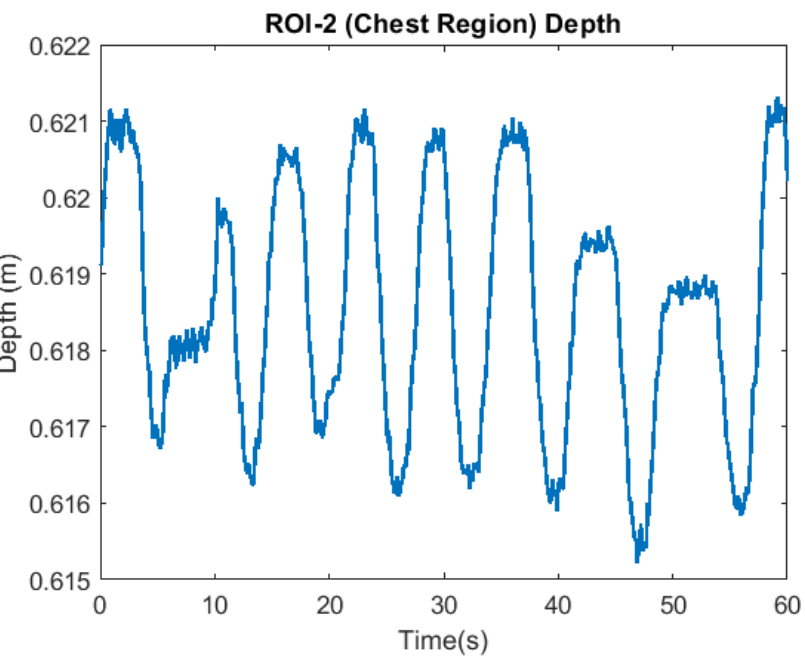
Figure 9. ROI-2 (chest) region depth signal, showing the periodic chest wall movement from respiration. The amplitude of the chest wall movement is 4 mm.